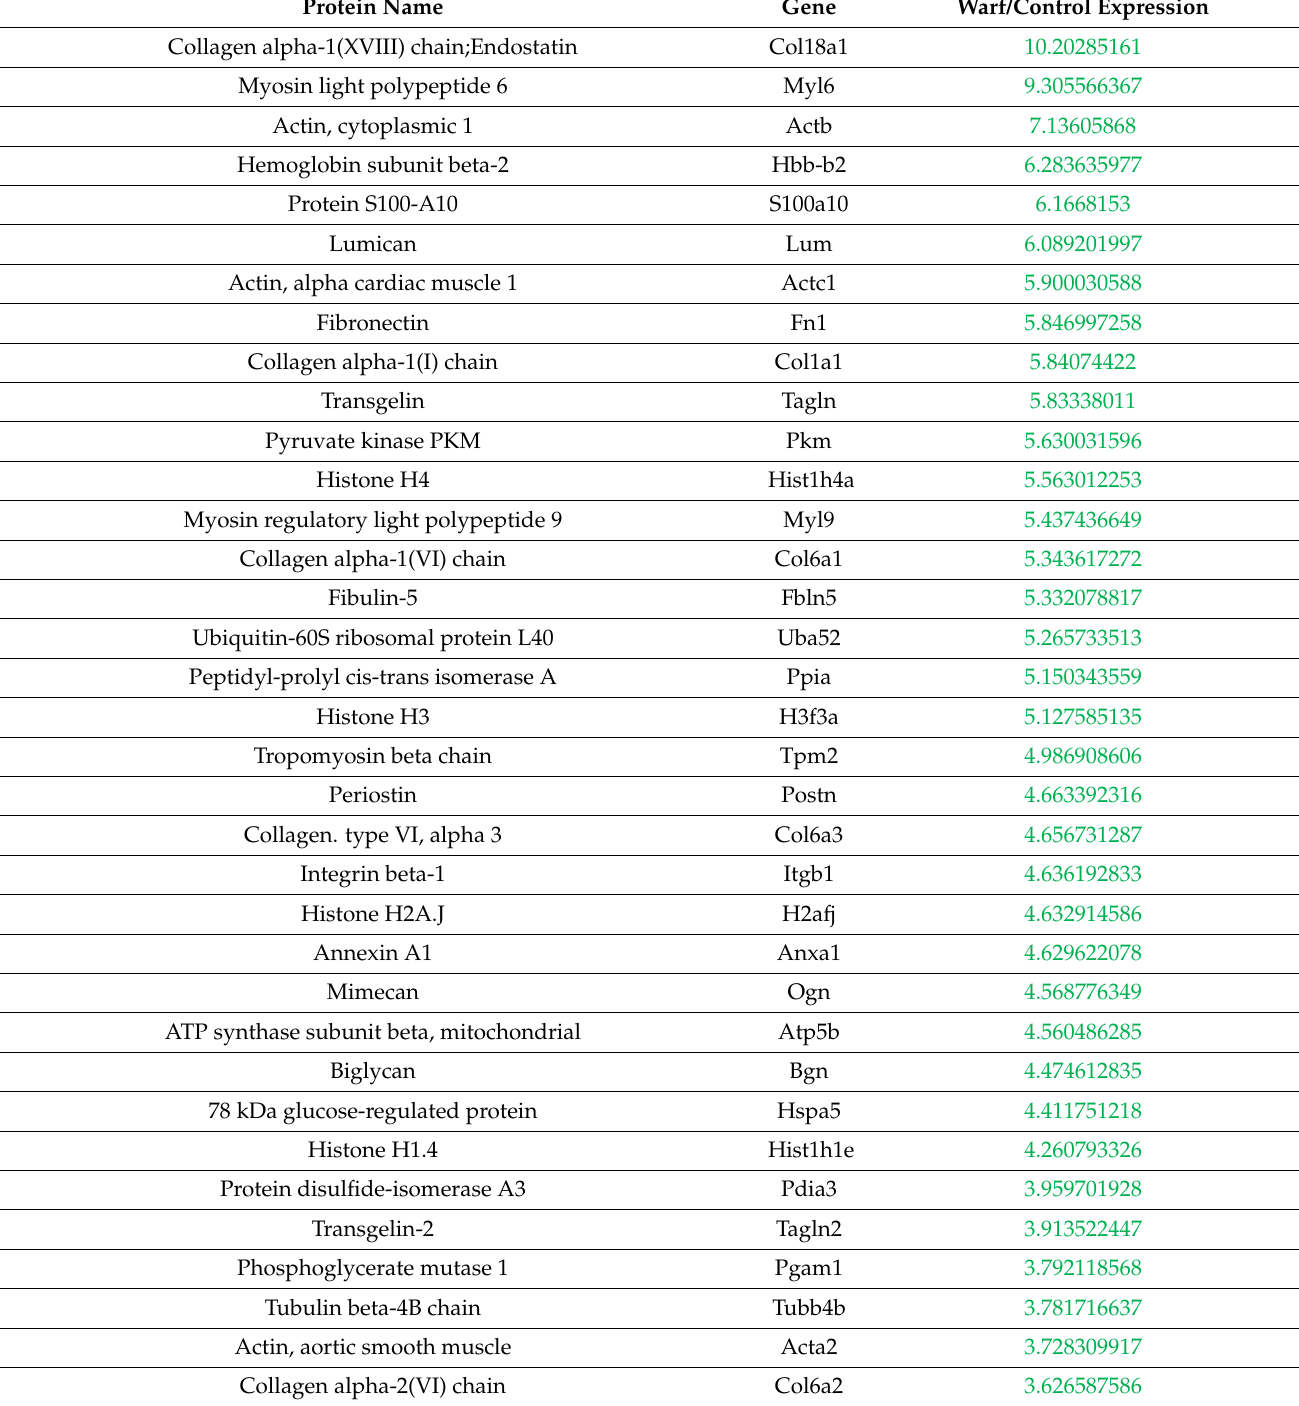
Table 1. List of differentially expressed proteins (DEP list) analyzed by MaxQuant. Fold change protein expression of warfarin vs. control aortic tissue is shown in green (upregulation) or red (downregulation). Protein